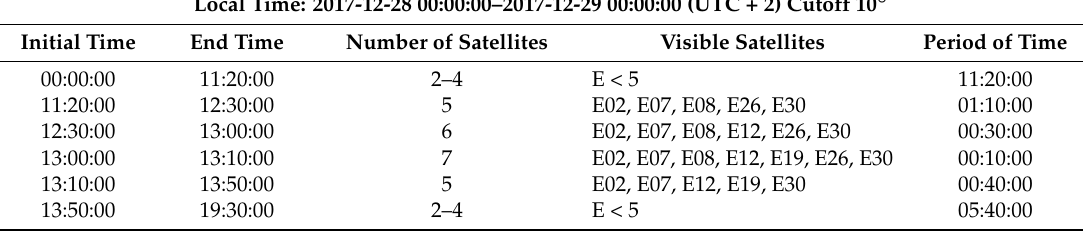
Table 1. Galileo satellites availability for the Day of Year: 362, 2017.